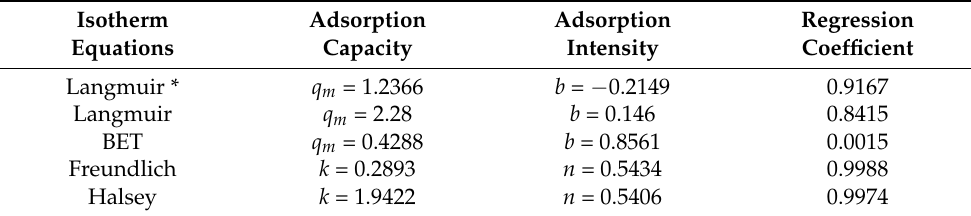
Figure 2. Linear description of CHL adsorption onto PGA-co-PDL NPs. Ce is the residual CHL concentrations in the suspension at equilibrium (mg/mL) and q is the amount of adsorbed CHL per unit weight of NPs. All models ( A ) Langmuir, ( B ) BET, ( C ) Freundlich ( D ) Halsey were fit utilizing concentrations of 2–20 mg/mL; however, the Langmuir model was also fit to low concentrations (0–8 mg/mL) (black) ( n = 3). Table 1. Adsorption parameters obtained by linear regression from the isotherm models.